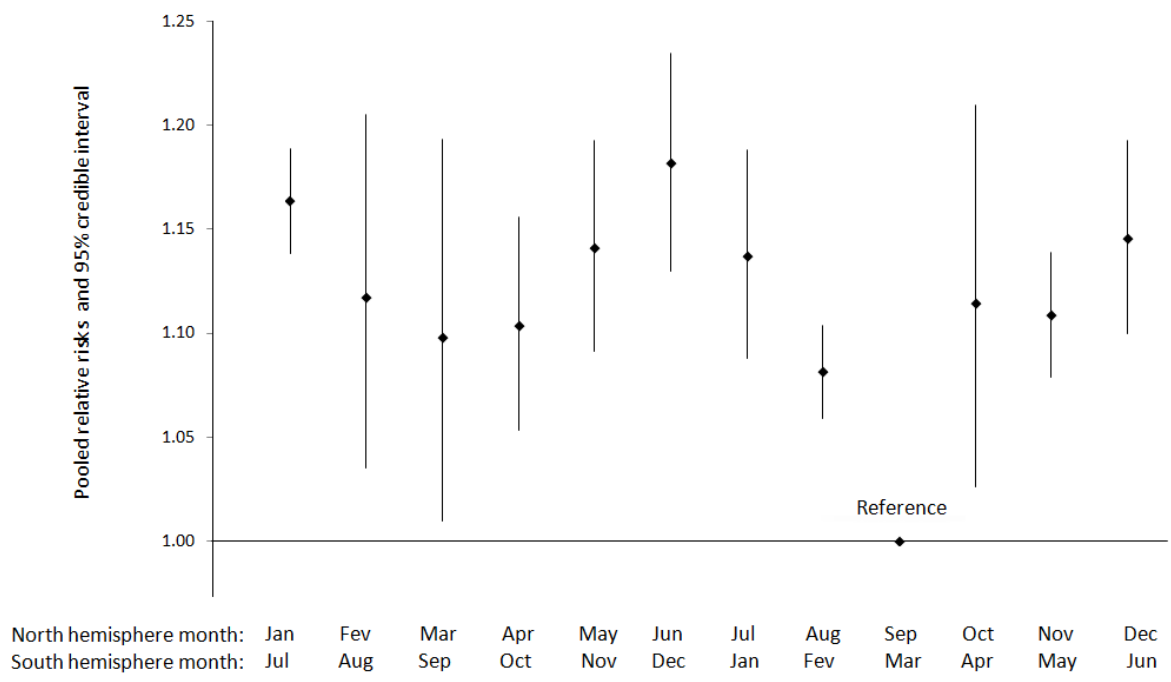
Figure 4. Pooled relative risks and 95% credible interval for the variation in preterm birth incidence by month of birth ( N = 63,227,292